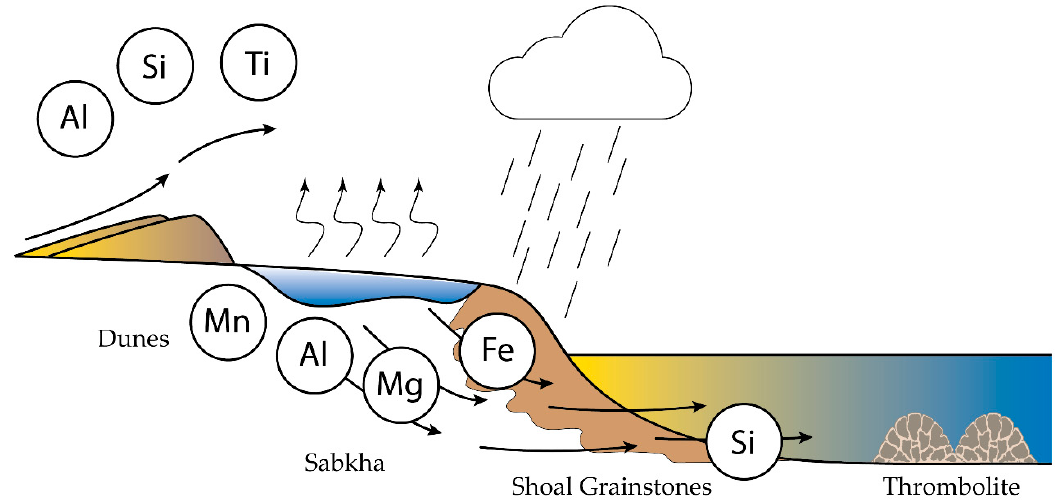
Figure 6. E ff ects of various elements within the depositional setting of the paleoenvironment of the Smackover Formation. Arrows indicate the possible generalized flow of elements by wind or water.